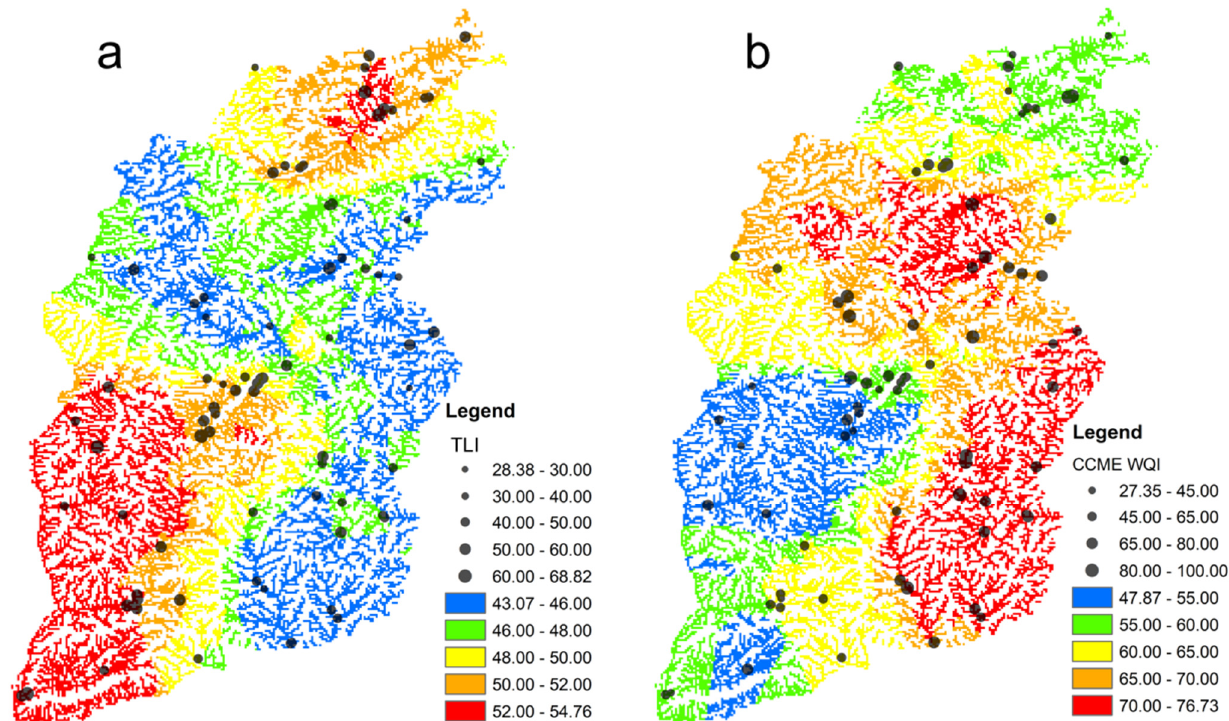
Figure 5. Spatial distribution of the eutrophication state and water quality in different Shanxi’s rivers. ( a ) TLI index; ( b ) CCME WQI index. Table 3. Results of the eutrophication state (TLI) and water quality (CCME WQI) in different watersheds and rivers. Watershed